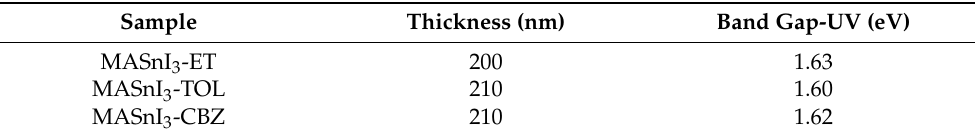
Table 3. Bandgap variation for MASnI 3 calculated from the UV–visible spectra, using diethyl ether, toluene, and chlorobenzene.